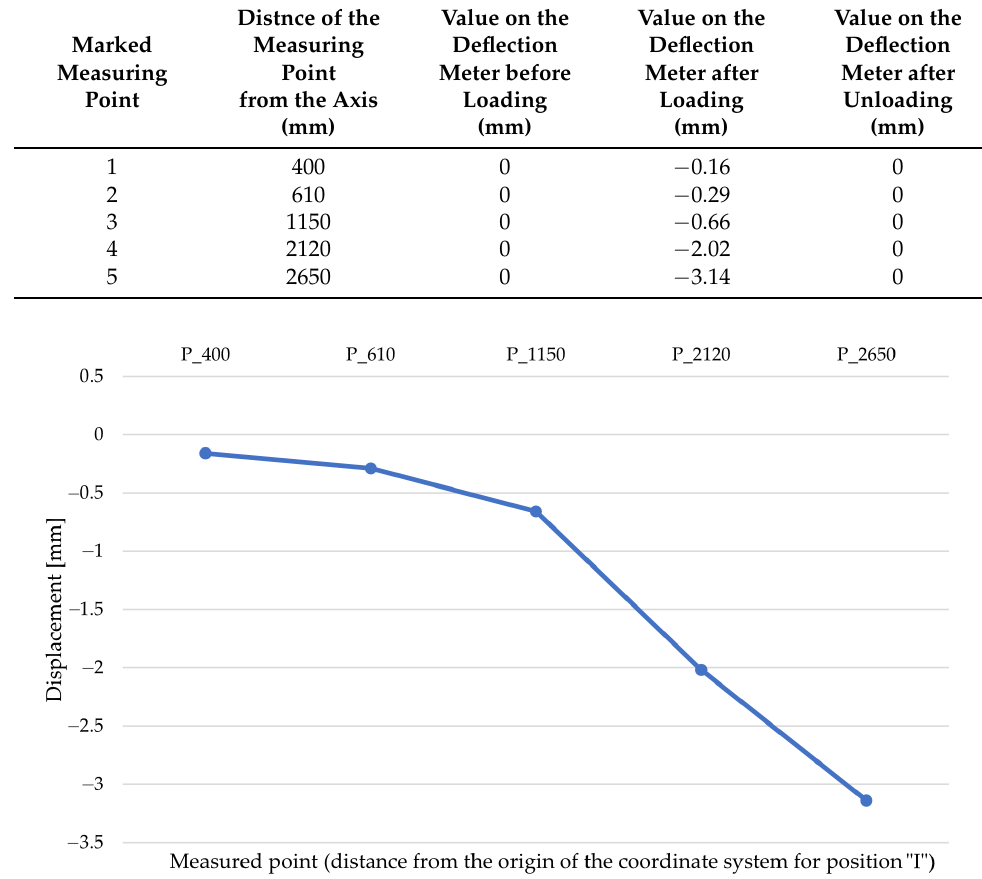
Figure 7. Results of displacement measurements in the z -axis with a mechanical deflection